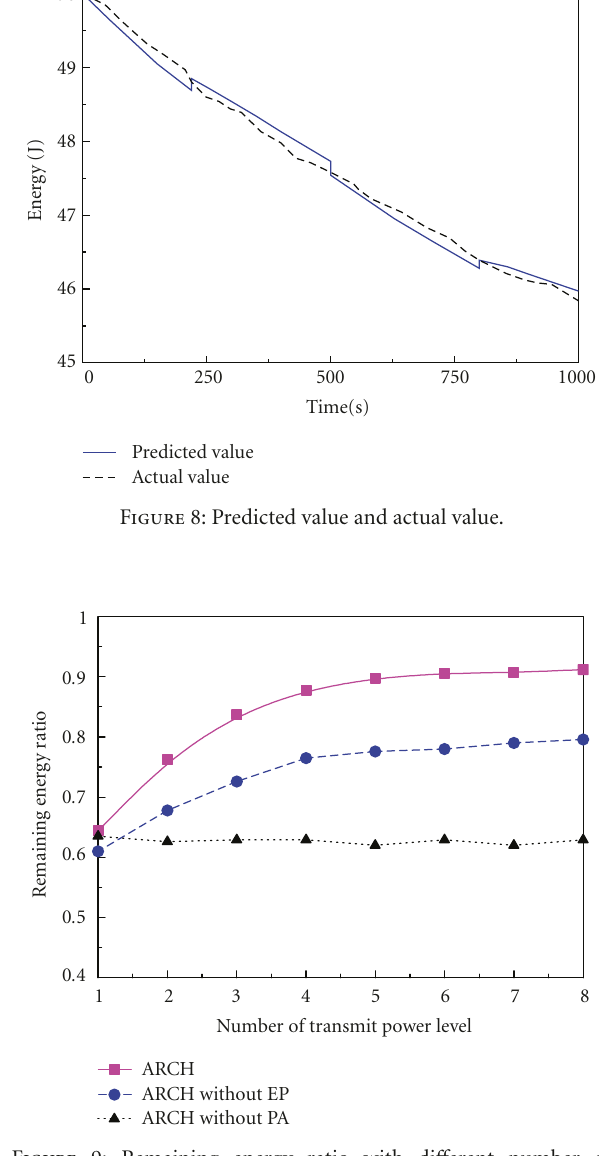
Figure 9: Remaining energy ratio with di ff erent number of transmit power